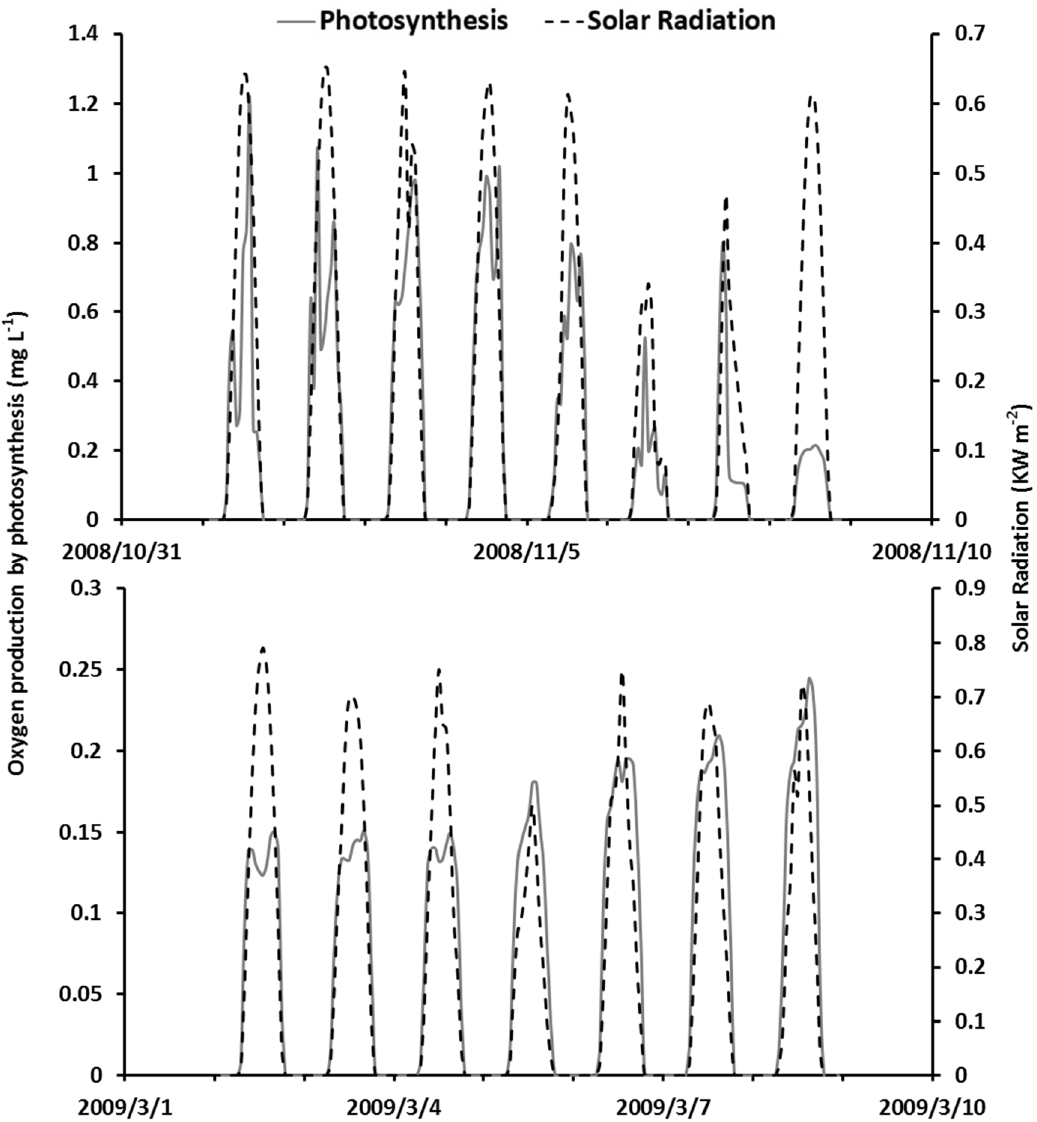
Figure 4. Comparison of hourly oxygen production by photosynthesis and intensity of solar radiation for selected days.